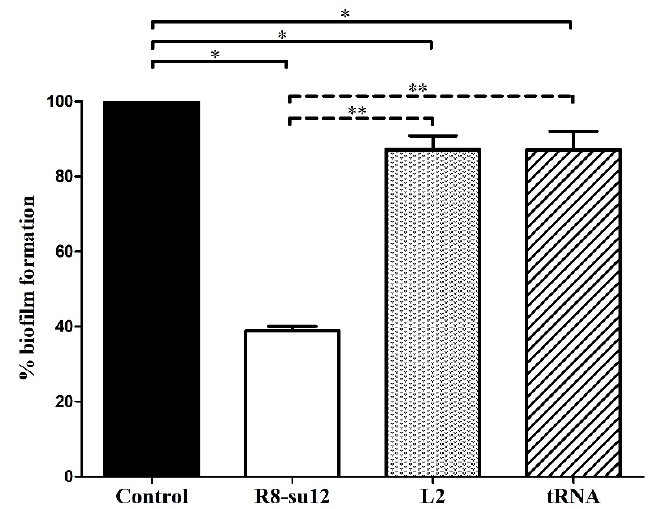
Figure 4. Reduction in biofilm formation by R8-su12 RNA aptamer. The S. suis SS 2, P1/7 was cultured in BHI broth with supplements (control) and in the presence of R8-su12 RNA aptamer (R8-su12), L2 RNA aptamer (L2), and baker’s yeast tRNA (tRNA). After 3 days of incubation without shaking, production of biofilm was determined using crystal violet biofilm assay. Percentage of S. suis SS 2, P1/7 biofilm formation was calculated. * indicates p < 0.05 and ** indicates p < 0.001 using the one-way ANOVA test.